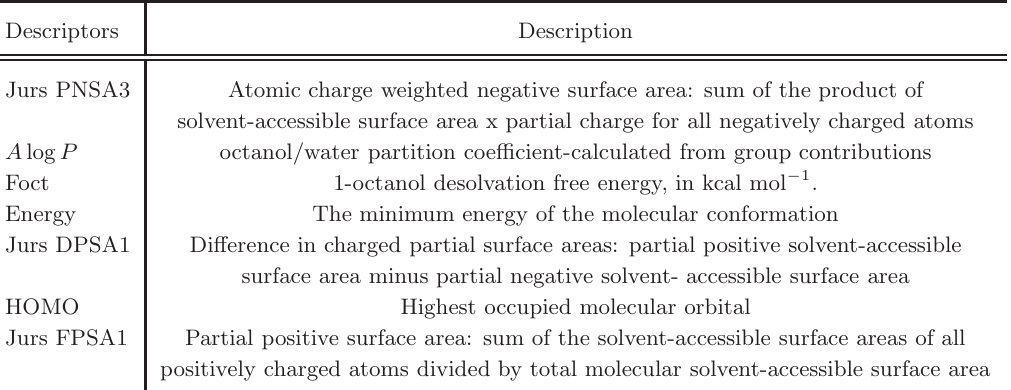
Table 4 Details of descriptors used in the